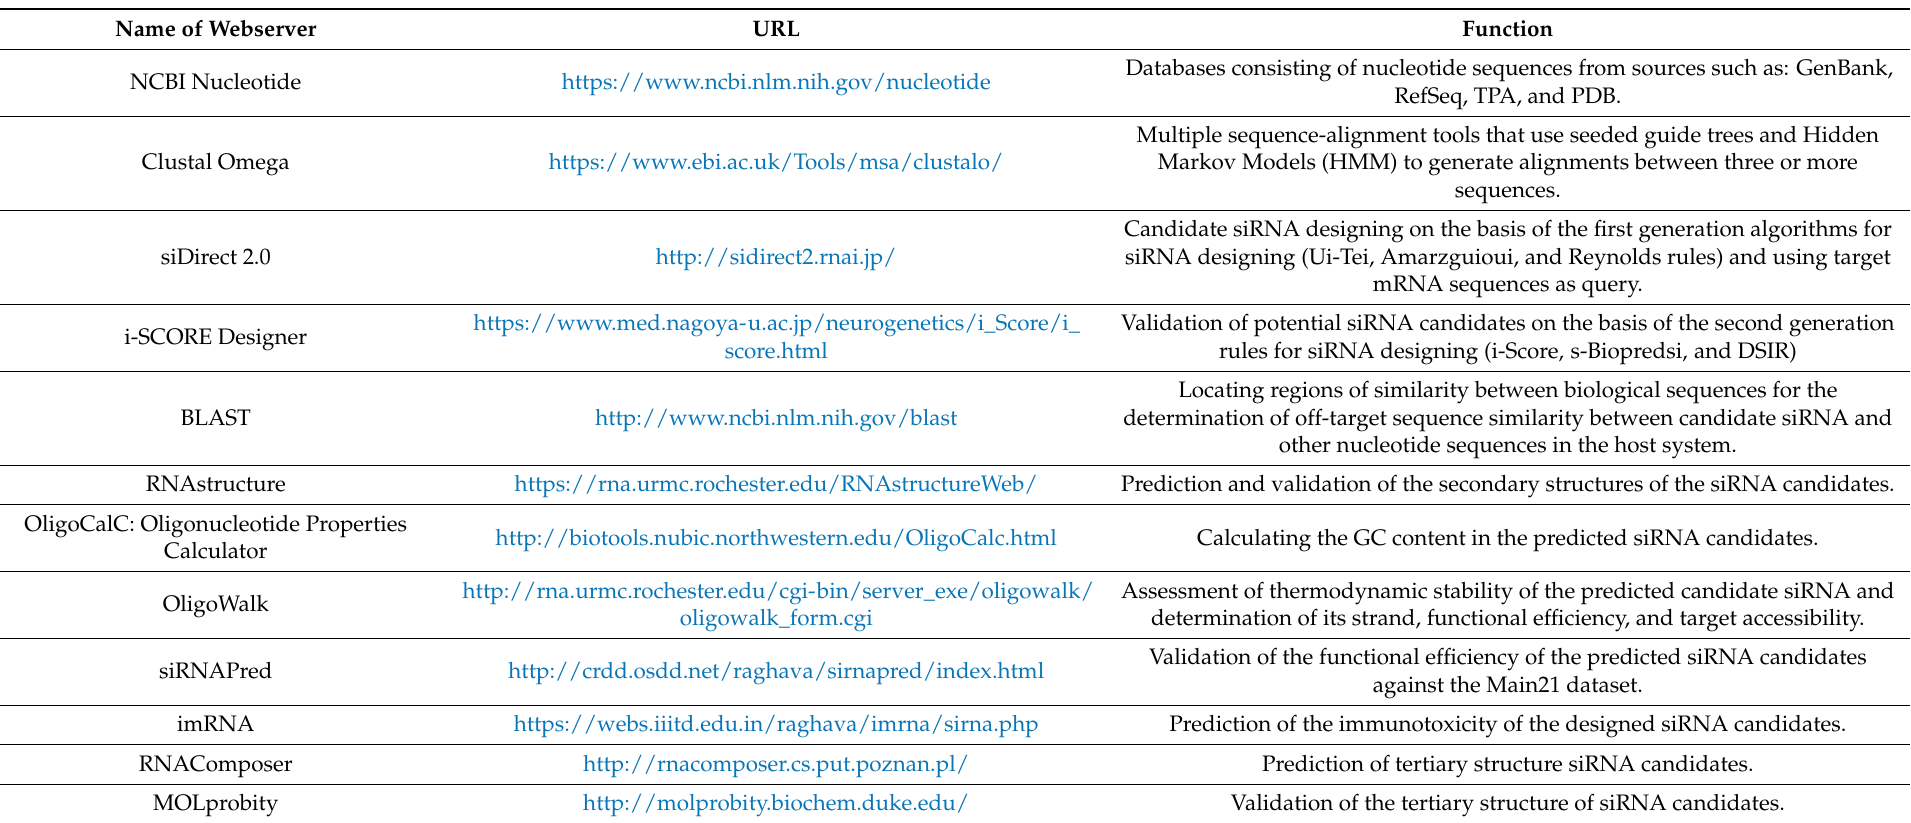
Table 1. List of webservers used in this study and their corresponding functions. (URL accessed on date 12 January 2021). Name of